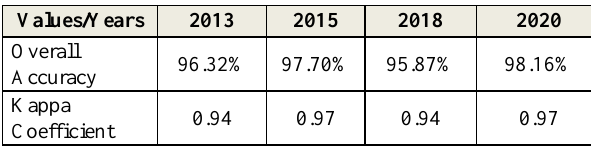
Table 2. Elmalı Basin Classification Accuracy